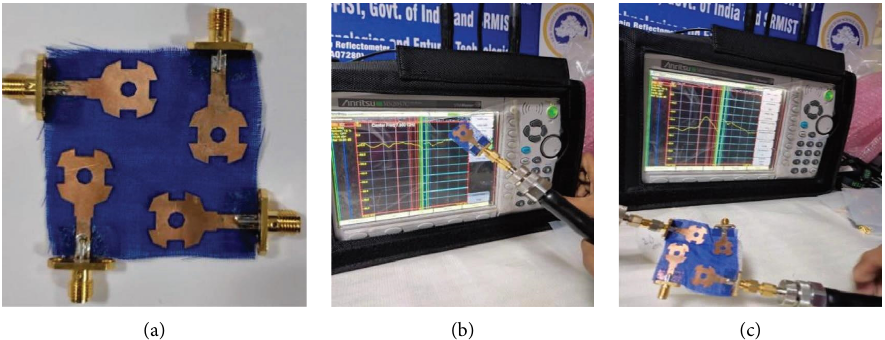
Figure 9: (a) Prototype of the MIMO antenna, (b) unit cell measurement using VNA, and (c) MIMO antenna measurement using